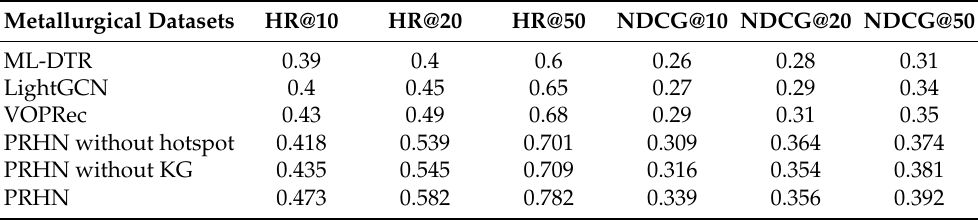
Table 4. Performance of different models on metallurgical datasets. Metallurgical